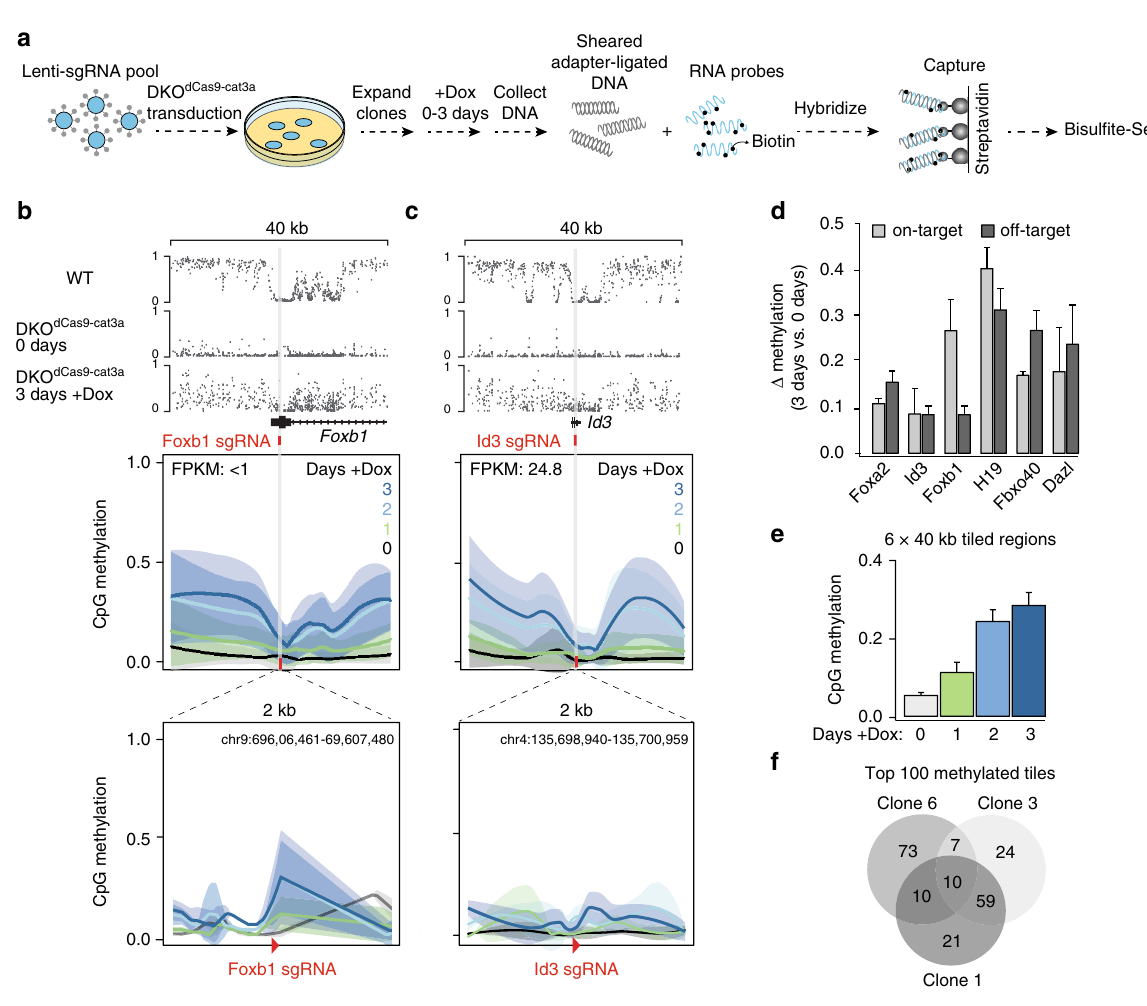
Fig. 2 Targeted bisul fi te sequencing surrounding multiple sgRNA targets. a Schematic describing the experimental design for the transduction of DKO dCas9-cat3a cells with multiple sgRNA constructs. Cells were collected at 0, 1, 2 and 3 days after Dox treatment. Extracted DNA was hybridized to capture probes for enrichment of target loci. See Methods section for more details. b Top: tracks displaying methylation levels for wild-type (WT) ES cells and DKO dCas9-cat3a at 0 and 3 days of Dox treatment. The target site for the Foxb1 sgRNA is displayed with 20 kb on either side, captured by our custom probes. Below: loess-smoothed methylation levels for 0, 1, 2 and 3 days of Dox treatment for the full region shown at the top, as well as a zoomed in region displaying the 2 kb surrounding the targeted locus. The sgRNA position is indicated as a red bar in the top part and red arrowhead in the bottom zoom in. c Same as in b , but for the Id3 locus. d The difference in methylation after 3 days of dCas9-cat3a expression for the on-target locus (200 bp downstream of the sgRNA) as well as all other captured 200 bp tiles with mean methylation level +/- 0.05 of the on-target locus in WT ES cells (collectively termed “ off- target ” ). Error bars display standard deviation for three clones. e Mean methylation for all CpGs within six 40 kb target regions that are covered in three independent clones over the Dox time course. Error bars display standard deviation for the three clones. f Venn diagram showing the overlap between the top 100 most highly methylated 200 bp tiles for the three independent